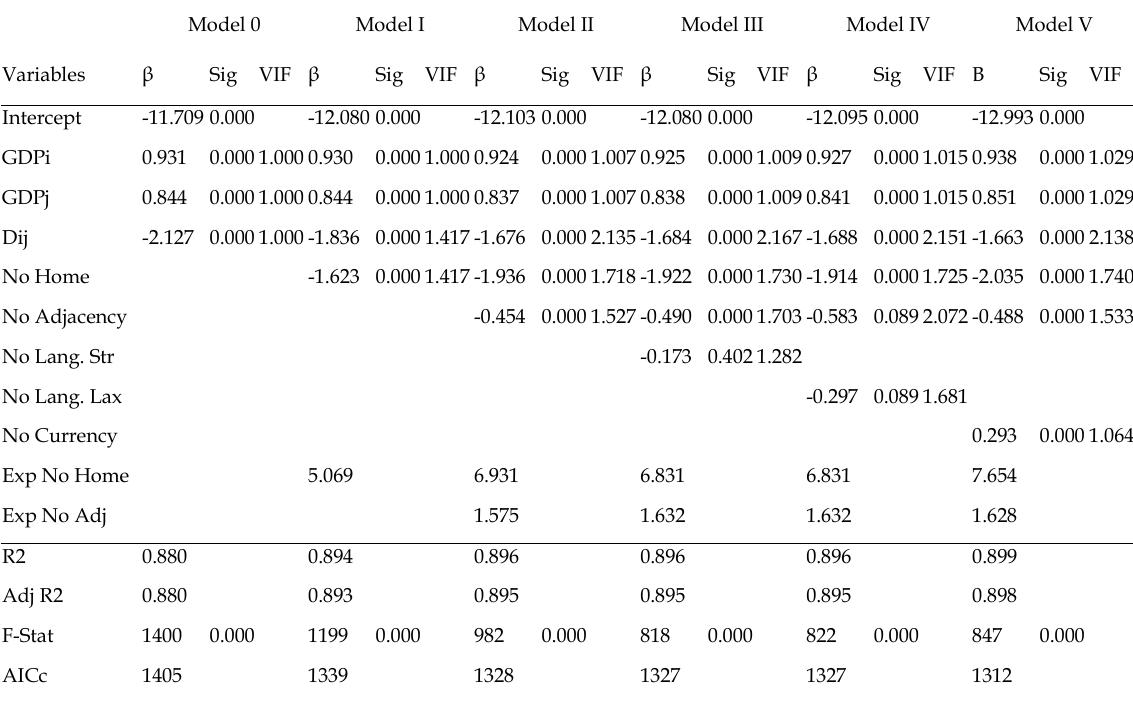
Table 2. Comparison of gravity models